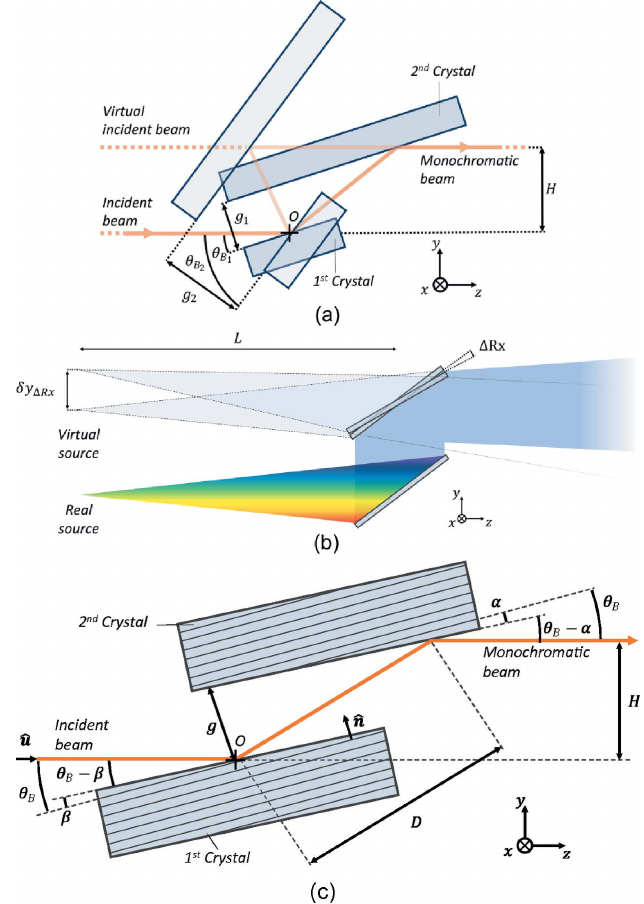
Figure 1 ( a ) DCM geometry according to the fixed beam impact point at the rotation axis O , showing Bragg angles (cid:2) and (cid:2) and the corresponding B 1 B 2 gaps g 1 and g 2 , keeping constant offset H between the monochromatic and incident beams. ( b ) Effect of DCM inter-crystal parallelism variation (cid:2) Rx in the position of the virtual source (cid:4) y (cid:2) Rx . ( c ) DCM geometry including (cid:5) and (cid:6) miscut angles in asymmetric crystals, where ^ uu represents the unit vector of the incident beam, ^ nn the unit vector normal to the diffraction planes, which is made parallel to the gap g that defines the offset H , and D is the distance traveled by the beam between crystals [adapted from Sterbinsky & Heald